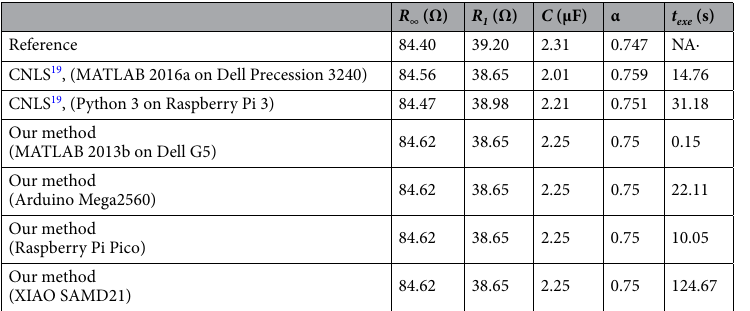
Table 3. Comparison of estimated values of model parameters using different hardware platforms. NA Not